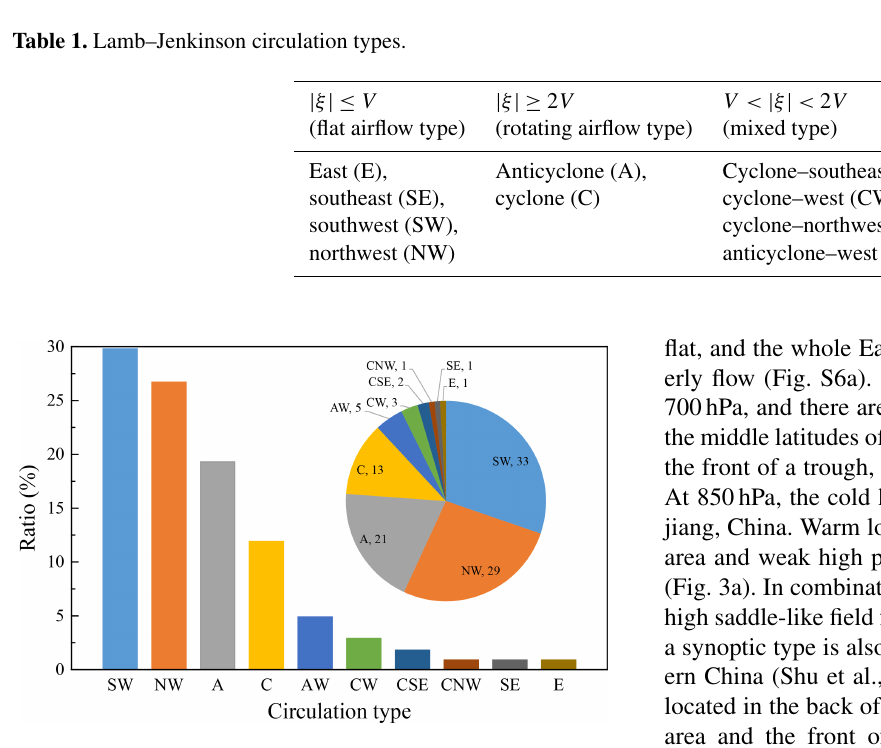
Figure 2. Frequency distributions of 10 circulation types for the heavy pollution days of 2013–2018 over Jingzhou. The occurrence numbers of each type are shown. The 10 circulation types include southwest (SW), northwest (NW), anticyclone (A), cyclone (C), anticyclone–west (AW), cyclone–west (CW), Cyclone–southeast (CSE), Cyclone–northwest (CNW), southeast (SE) and east (E), re-